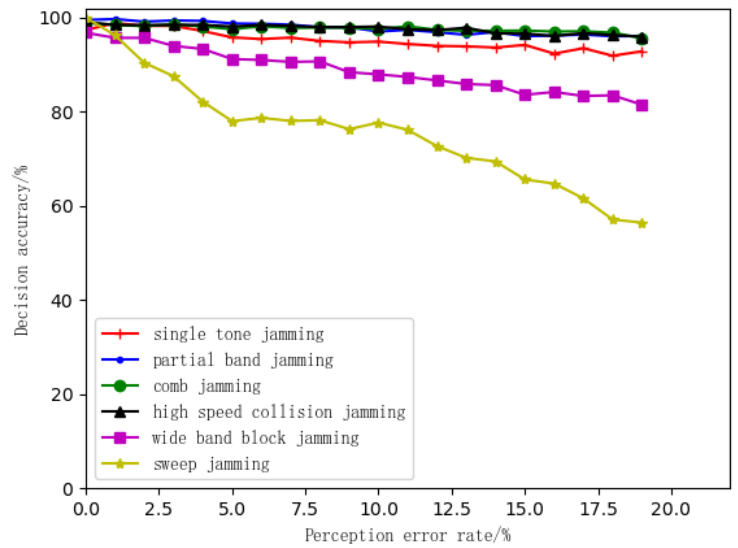
Figure 7. Decision accuracy curves of unknown jamming patterns under perception errors.